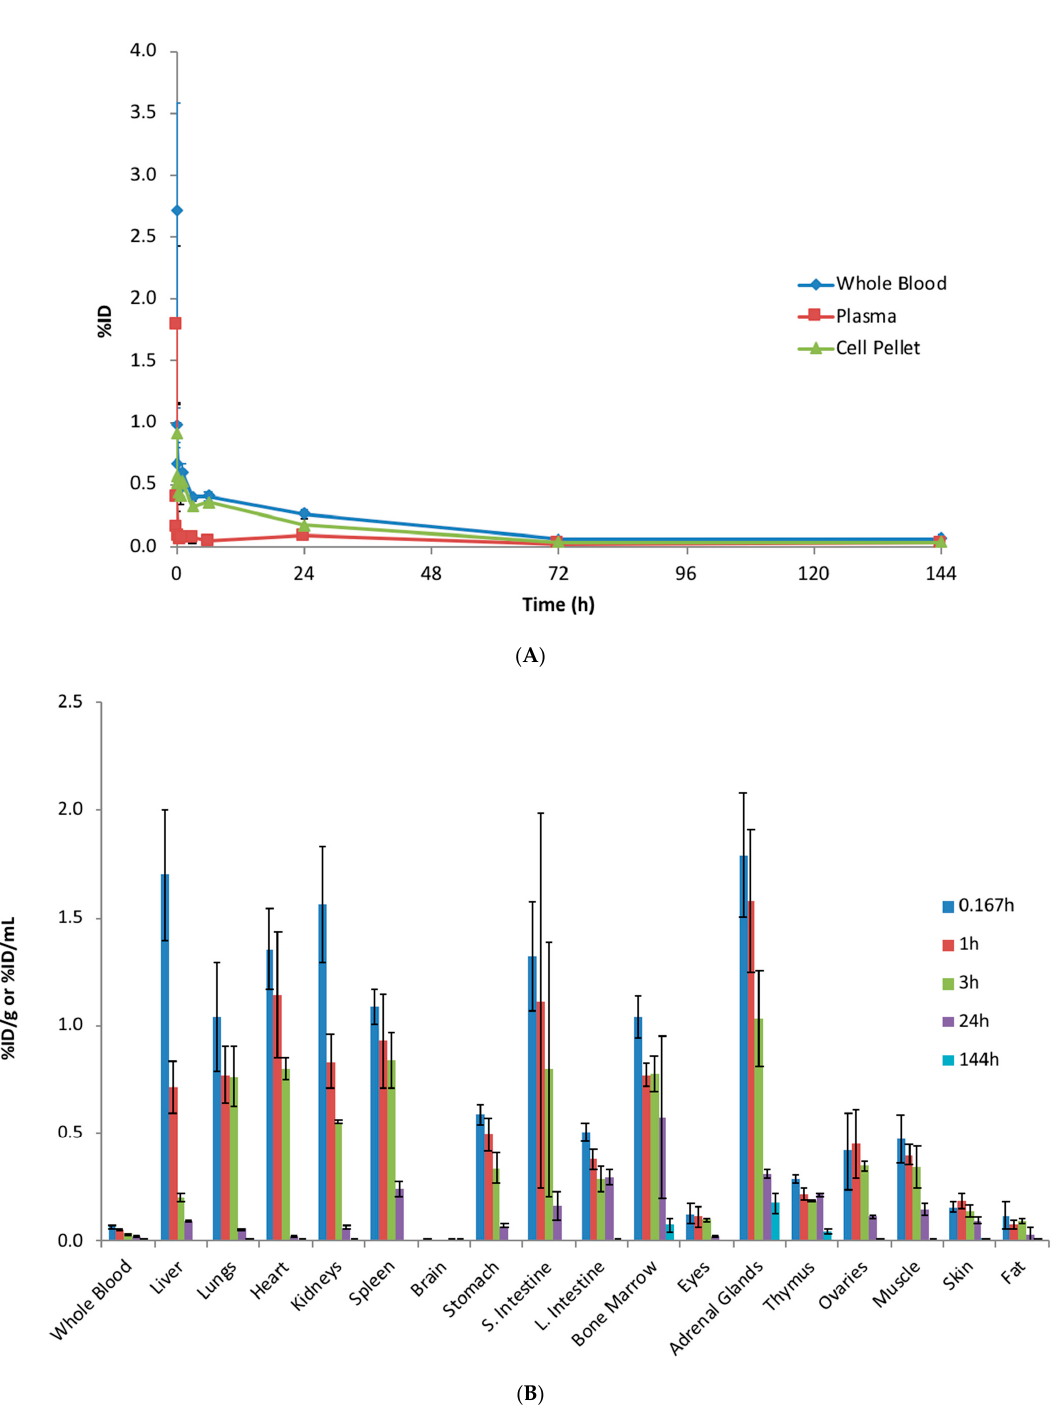
Figure 2. The systemic pharmacokinetics (PK) and tissue biodistribution of unconjugated [ 3 H]-MMAE following a single intravenous (IV) administration. ( A ) Radioactivity of [ 3 H]-MMAE (as a percentage of the injected dose) from the whole blood, plasma, and cell pellets in rats up to 144 h post administration. A six- to eight-fold higher level of radioactivity was observed throughout the study in the cell pellets isolated from blood compared to the plasma, suggesting a strong partition to red blood cells. ( B ) Radioactivity of [ 3 H]-MMAE from blood and multiple tissues isolated from rats at various time points post IV administration. The data are represented as the mean ± standard deviation (SD). n = 3 per time point. S. Intestine: small intestine; L. Intestine: large